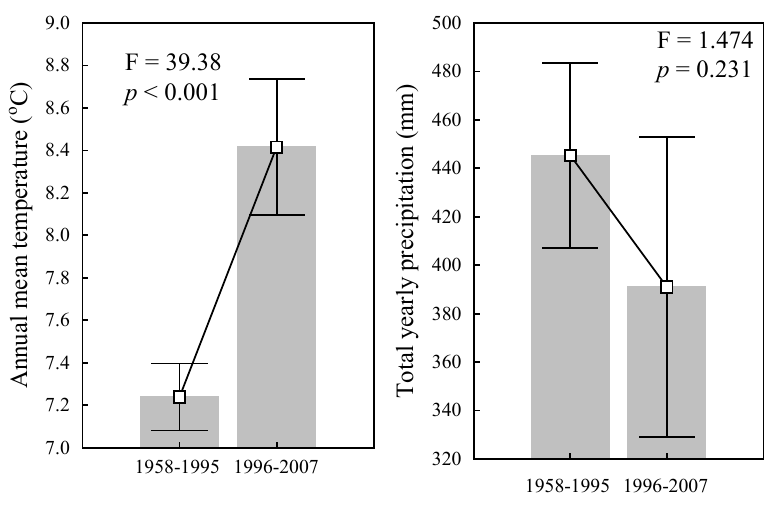
Figure 5. Comparison of annual mean temperature and total yearly precipitation between 1958–1995 and 1996–2007 by